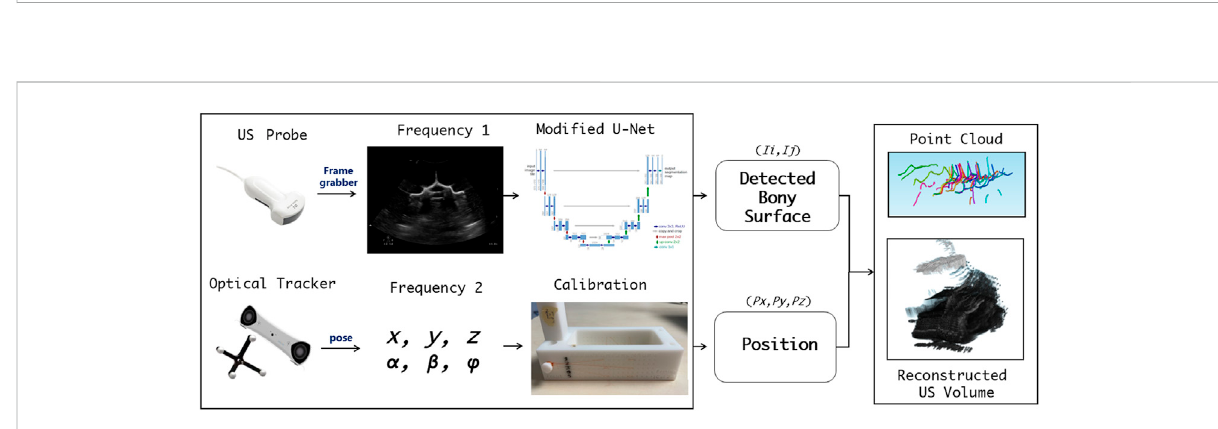
FIGURE 3 Work fl ow for acquisition, calibration, segmentation, compounding, and visualization of the US